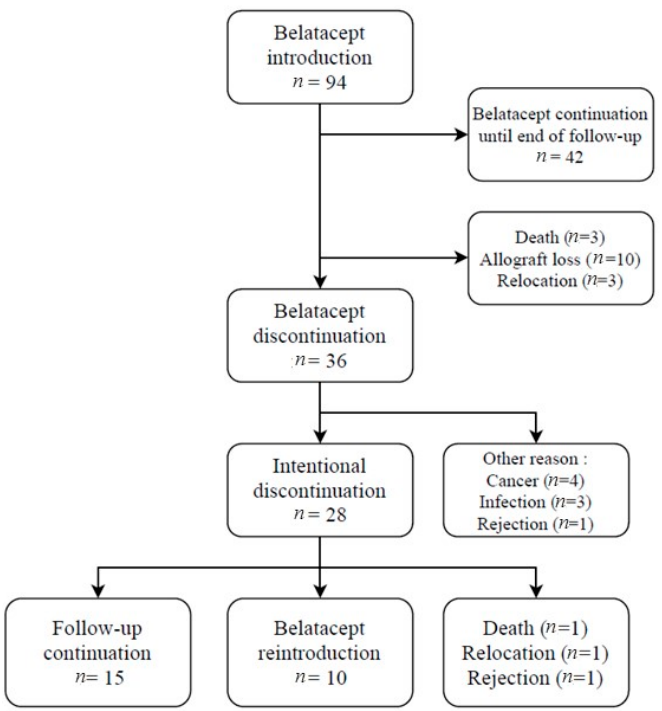
Figure 1. Flowchart of the study.